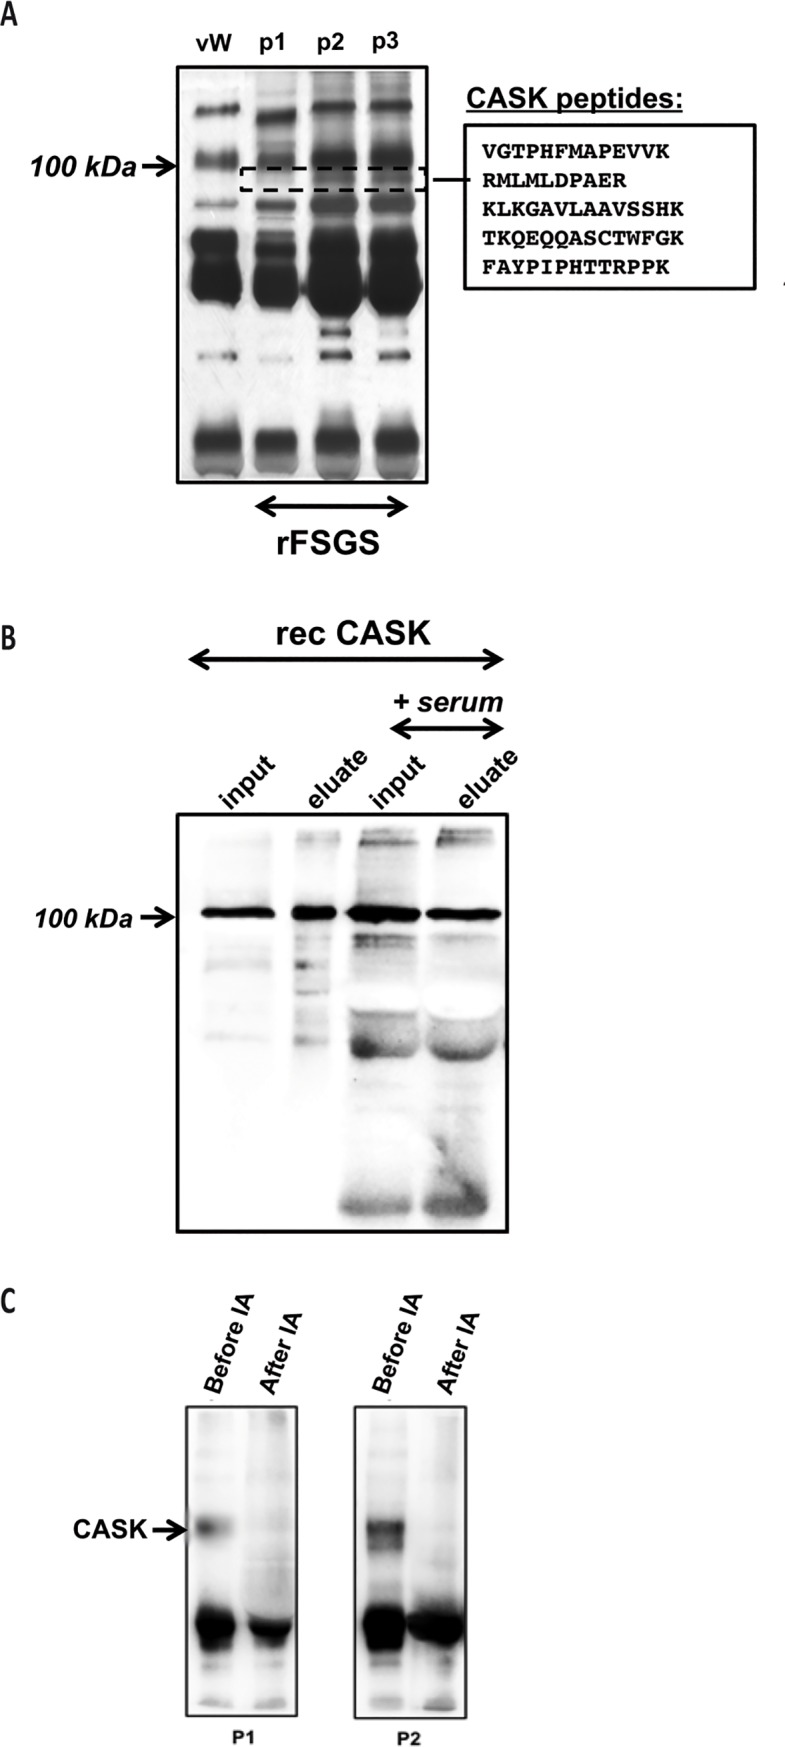
Identification of CASK in the sera of patients affected by rFSGS.A) PAGE of samples from patients with rFSGS or a von Willebrand’s disease and eluted from protein-A columns after immunoadsorption. Dashed box: Peptidic sequences identified by MS from three rFSGS patients (p1, p2, p3). vW: Patient treated for von Willebrand's disease; P1–P3: three patients having a rFSGS. B) Affinity of CASK to protein-A beads. rCASK binds to protein-A even in the presence of nonspecific human immunoglobulins (in normal serum). All incubated CASK (input) was recovered after the acidic elution of protein-A (eluted). The presence of immunoglobulins did not seem to affect this interaction. C) CASK was efficiently removed by protein-A immunoadsorption from sera from rFSGS patients. CASK was only observed in rFSGS sera before immunoadsorption and was depleted after the procedure. CASK was evaluated by anti-CASK Western blot analysis.